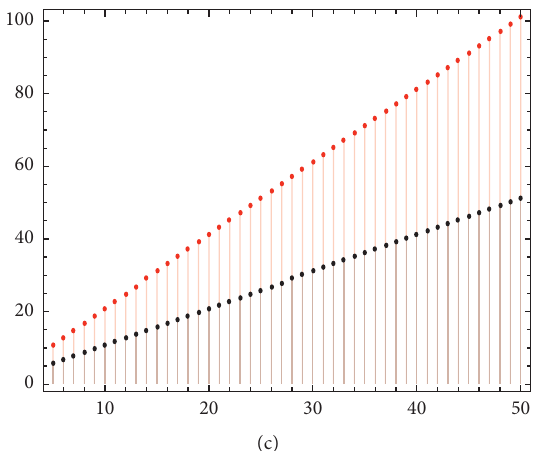
Figure 7: Graph of sequences of rotationally symmetric hexagonal planar networks H i